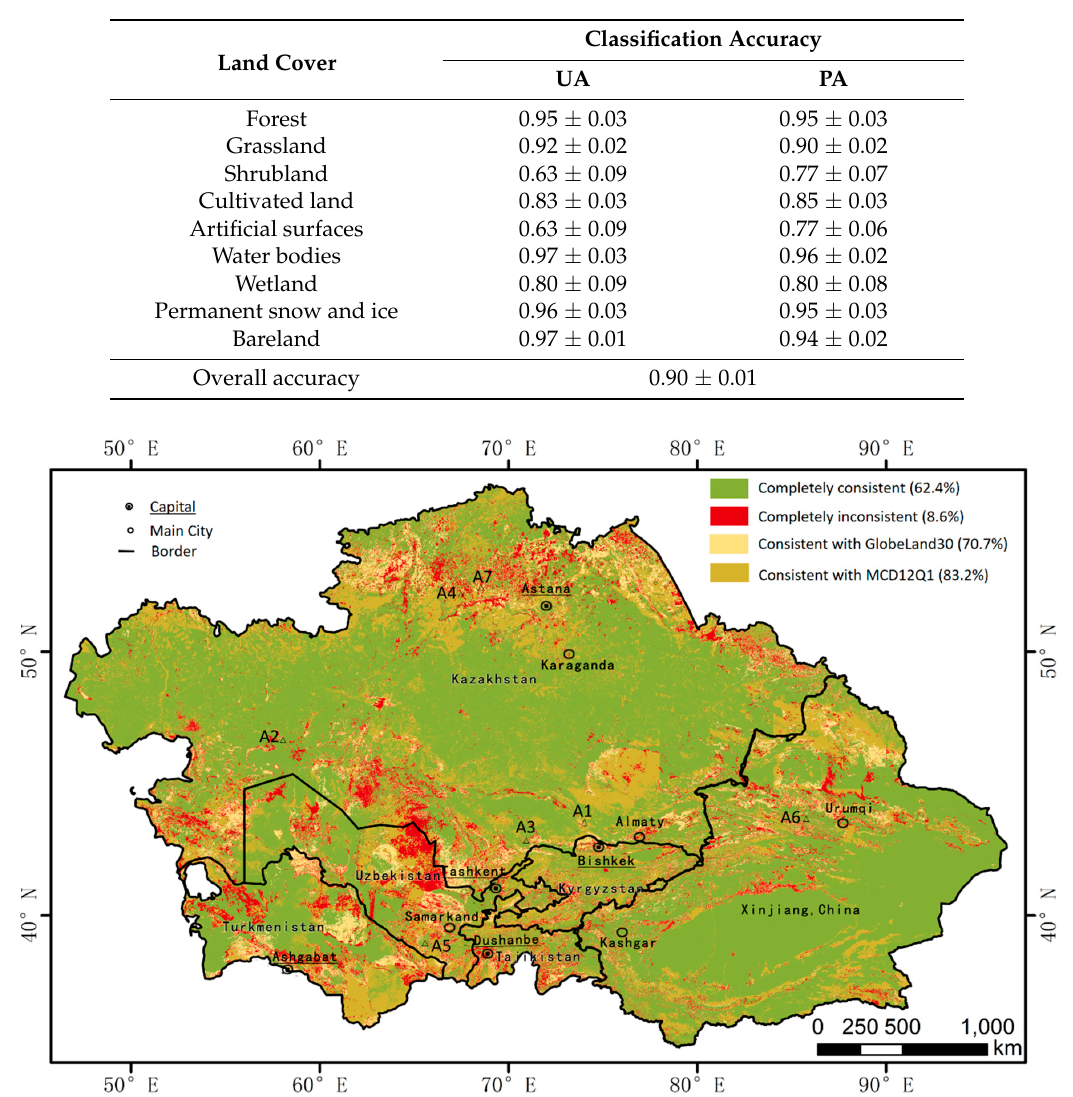
Table 2. User’s accuracies (UA), producer’s accuracies (PA) and overall accuracy of Land cover classification from 2001 to 2017.